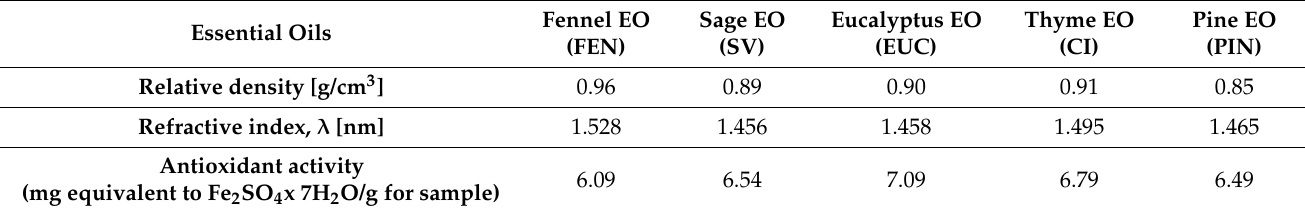
Table 3. Physical-chemical properties of obtained essential oils.